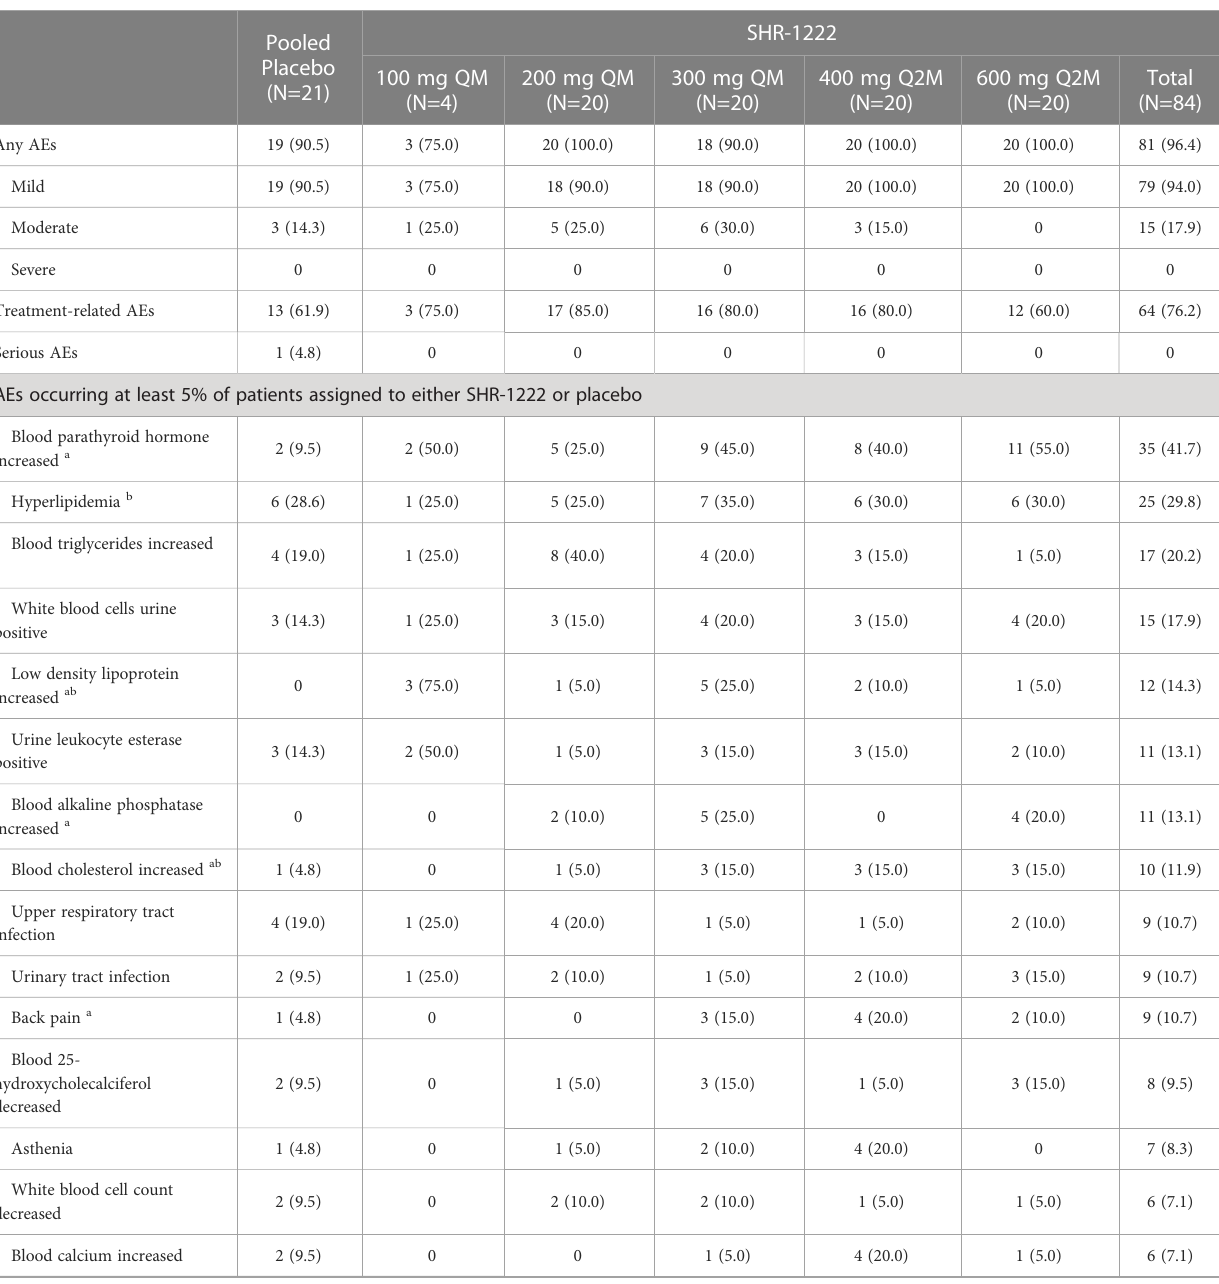
TABLE 2 Adverse events in the safety